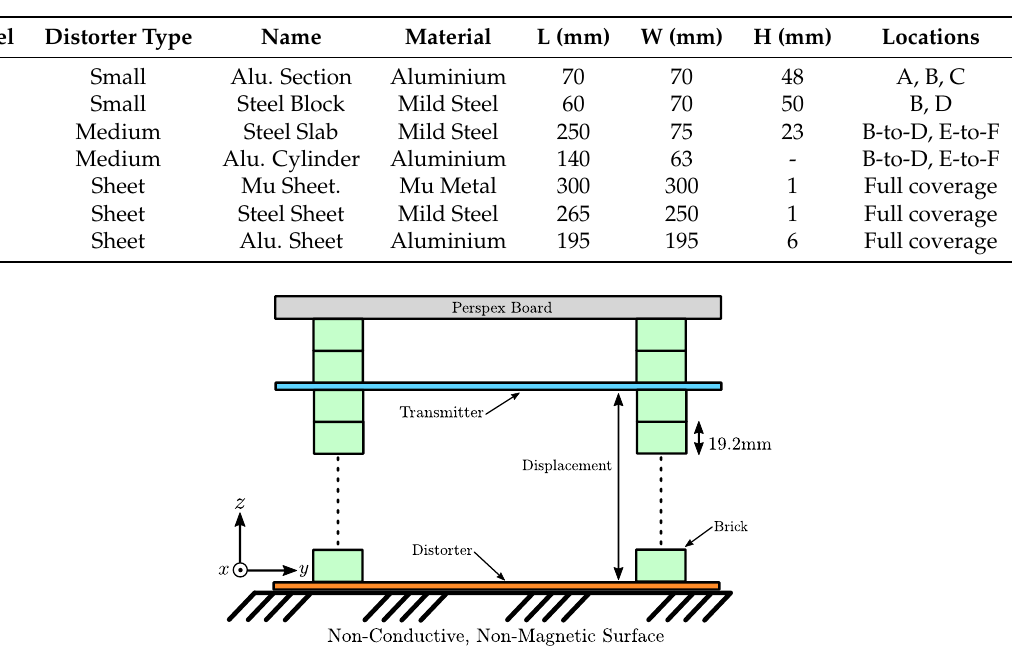
Figure 9. Side-view diagram of the modified transmitter board. The Duplo bricks allow adjustment of the displacement between the transmitter and distorter in increments of 19.2 mm. The Perspex board height is also adjustable, although this was kept at a constant height during the position error experiments. The experimental setup was placed on an all-wood